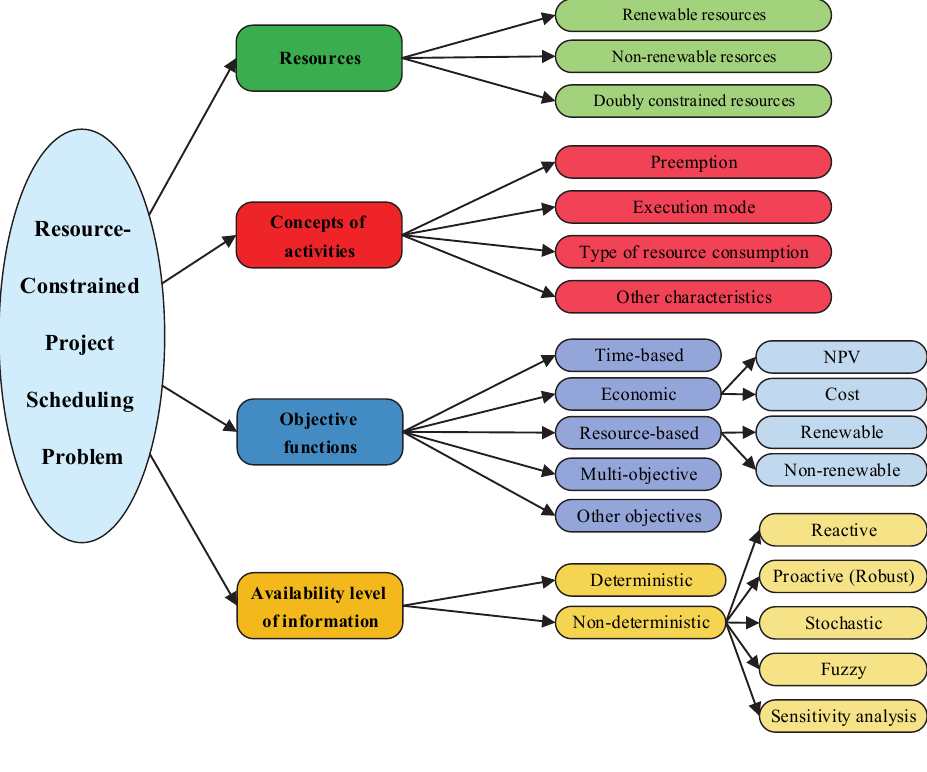
Fig. 1. Classification of resource-constrained project scheduling